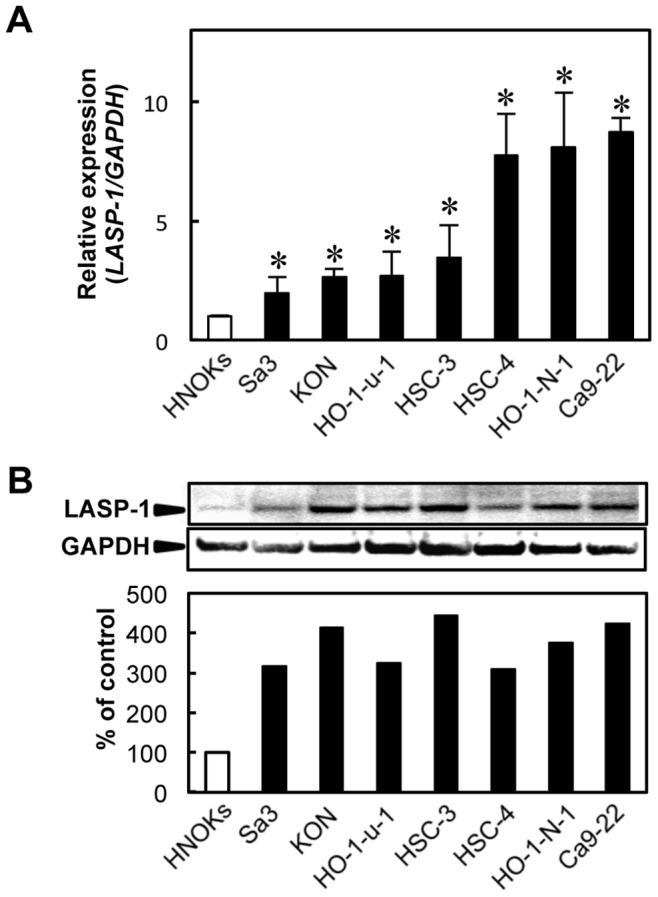
Evaluation of LASP-1 expression in OSCC-derived cell lines.(A) Quantification of LASP-1 mRNA expression in OSCC-derived cell lines by qRT-PCR analysis. mRNA expression levels are normalized to GAPDH. Significant up-regulation of LASP-1 mRNA is seen in seven OSCC-derived cell lines compared with that in HNOKs. Data are expressed as the means ± SEM of triplicate results (*P<0.007; Mann-Whitney U test with Bonferroni correction). (B) Immunoblotting analysis of LASP-1 protein in the OSCC-derived cell lines and HNOKs. LASP-1 protein expression is up-regulated in the OSCC-derived cell lines compared with that in the HNOKs. Densitometric LASP-1 protein data are normalized to GAPDH protein levels. The values are expressed as a percentage of the HNOKs.